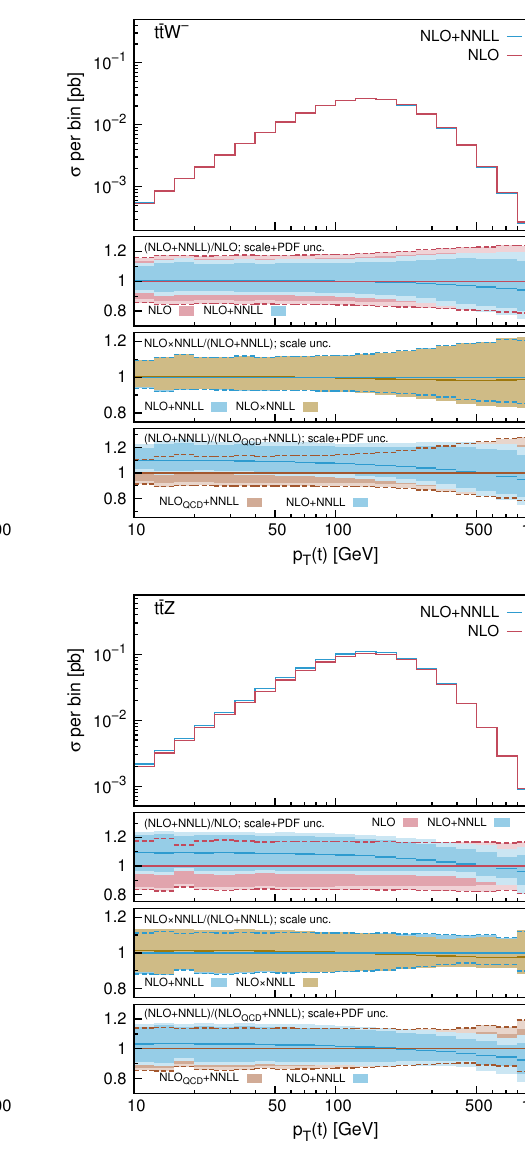
Figure 4 . Distributions di(cid:11)erential w.r.t. the transverse momentum of the top quark. Same structure as in (cid:12)gure